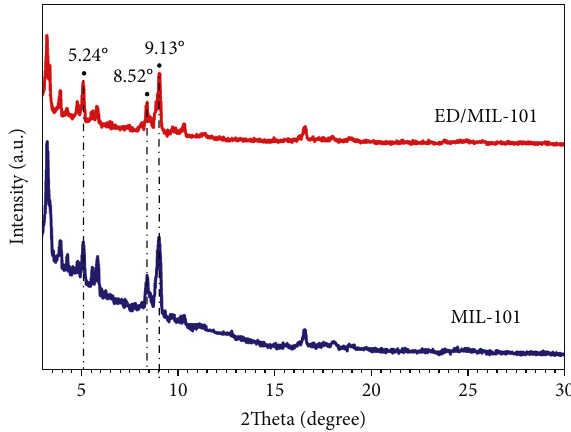
Figure 3: The XRD results of etched MIL-101 and